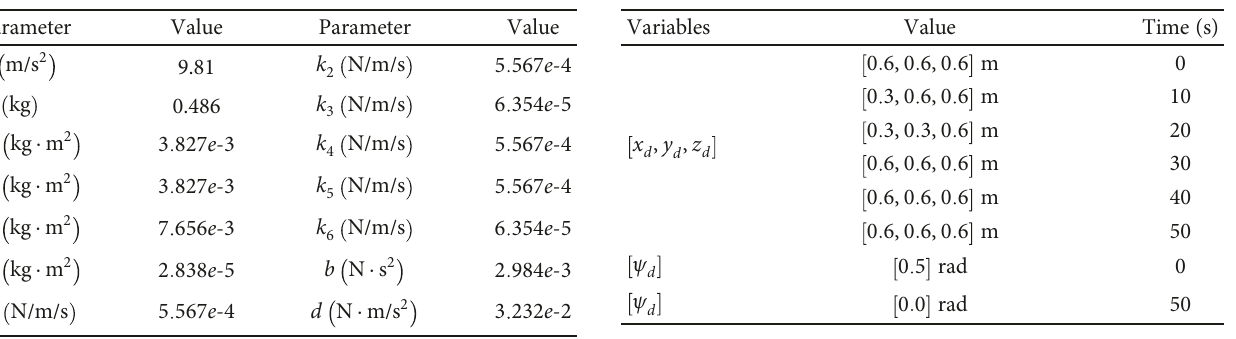
Table 1: Quadrotor parameters. Table 2: The reference trajectories of the position and yaw angle.